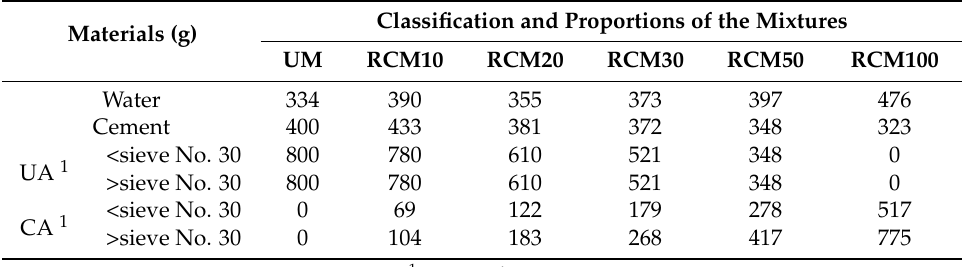
Table 2. Characteristic and proportions of the